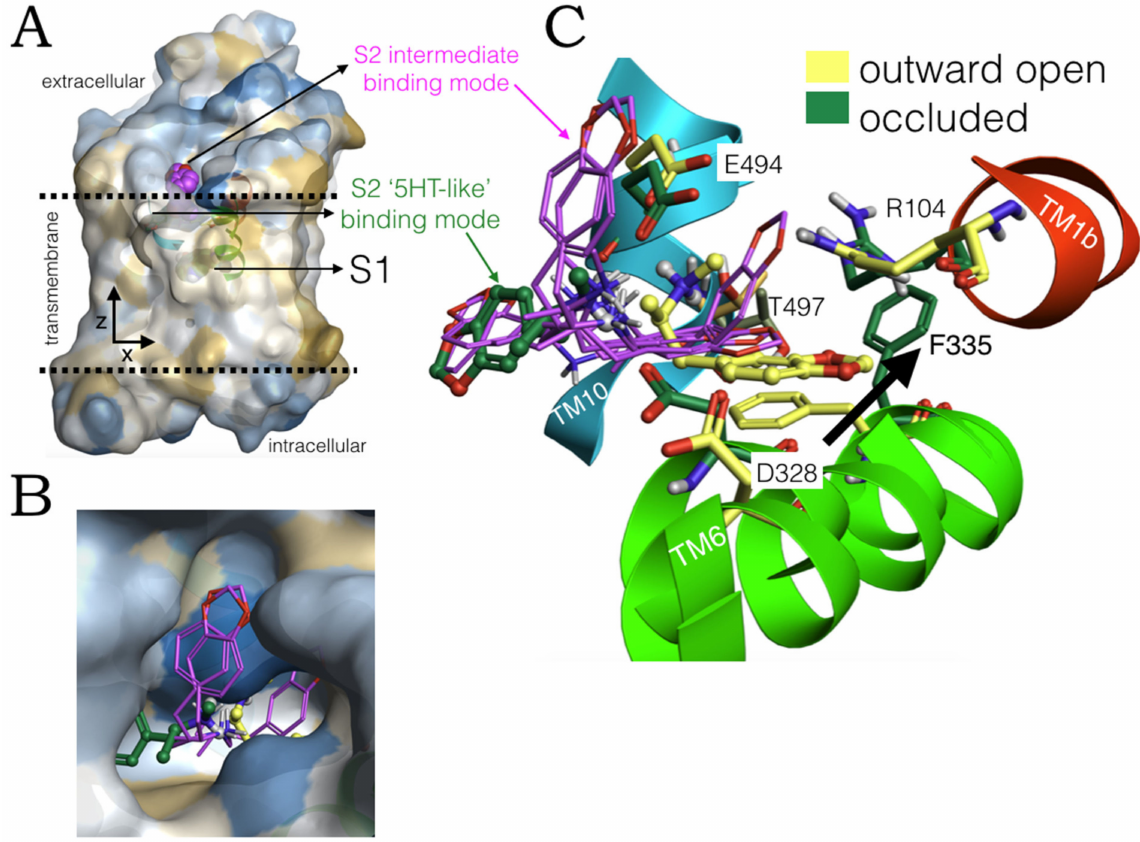
Figure 5. ( A ) Molecular surface of the hSERT complex in the occluded state showing the locations of MDMA at the central site and at S2. Including an intermediate configuration between the ‘5-HT-like’ and the ‘escitalopram-like’ orientation (in magenta). ( B ) Molecular surface of the binding pocket of S1 in the occluded state. The ‘5-HT-like’ binding mode in green, the ‘escitalopram-like’ binding mode in yellow and intermediate modes in magenta. Colour code: beige = hydrophobic, blue = polar. ( C ) Binding poses on S2 in the open outward and occluded states, ‘5-HT-like’ binding mode is in green, ‘escitalopram-like’ mode is in yellow, intermediate modes in magenta. The main participating binding residues are shown in the same colour